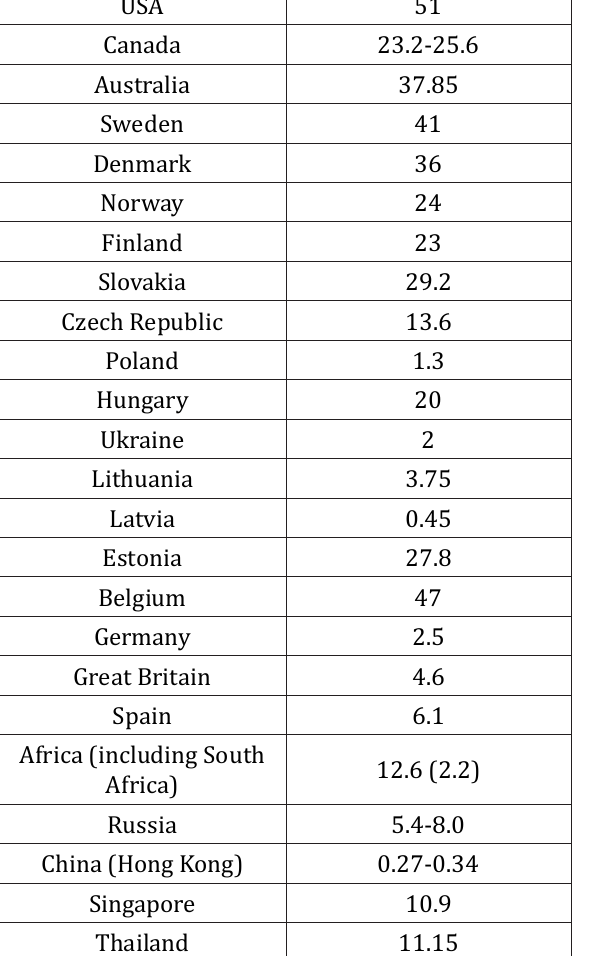
Table 1. Frequency of ECT use per 100,000 population in different countries.